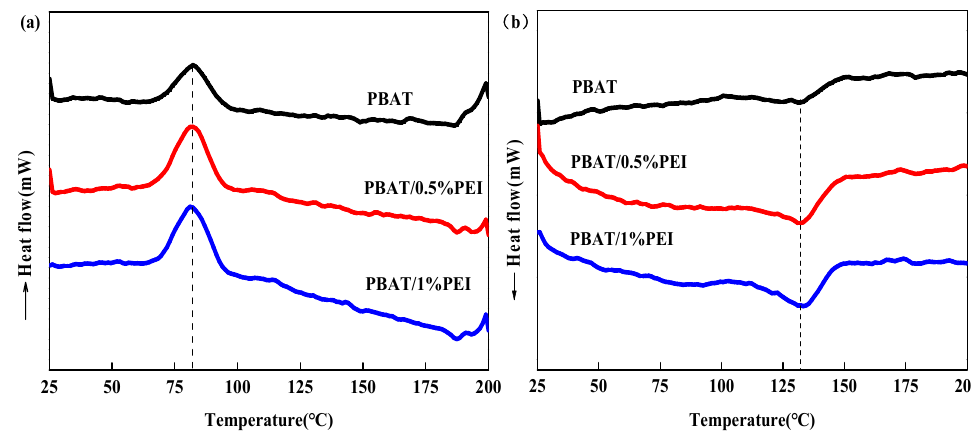
Figure 2. XRD for PBAT and PBAT/PEI films.